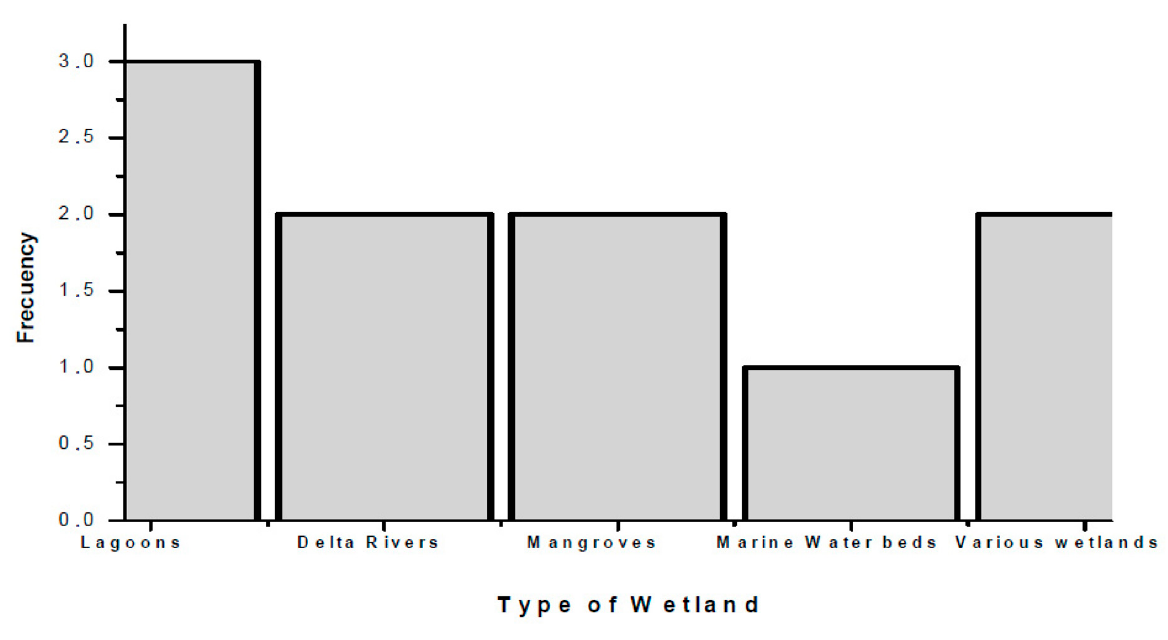
Figure 3. Frequency distribution of incident factors of wetland loss in Africa.